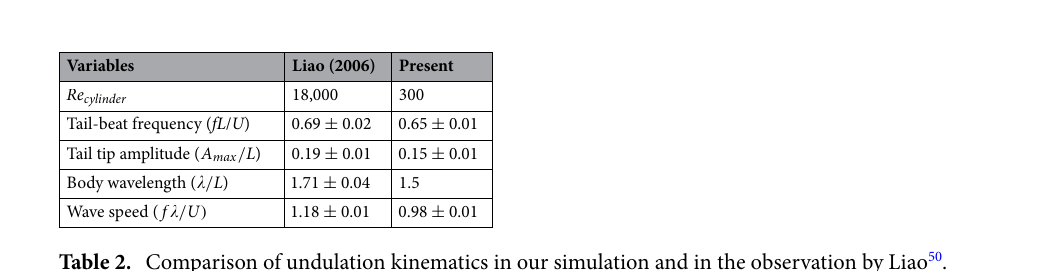
Table 2. Comparison of undulation kinematics in our simulation and in the observation by Liao 50